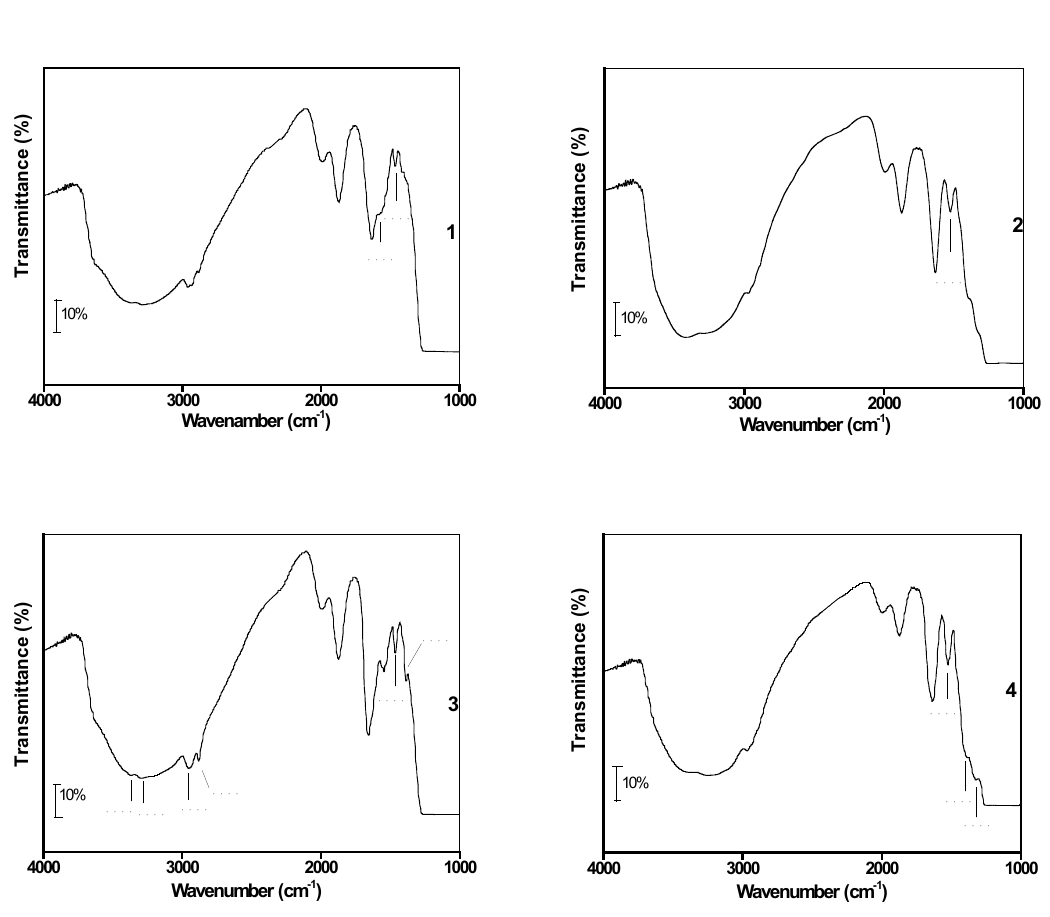
Figure 2. IR spectra of adsorbents 2 and 3 before (curves 1, 3) and after (curves 2, 4 respectively) adsorption of mercury(II)